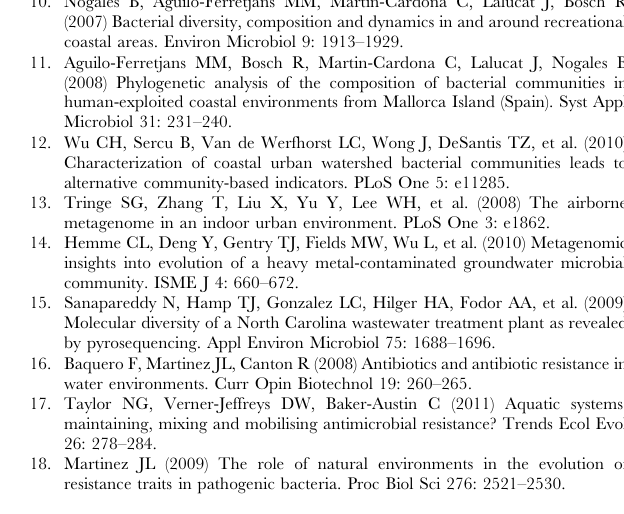
Table S1 Puget Sound 454 sequence reads with $ 80% similarity and an alignment length $ 50 amino acids to sequences within the expanded Antibiotic Resistance Genes Database (ARDB + ). Table S2 Plasmid sequences in the NCBI RefSeq database that match contigs from the Puget Sound and wastewater treatment plant (WWTP) effluent metage- nomic datasets. Table S3 Plasmid sequences in the NCBI RefSeq database that match sequence reads from the Puget Sound and wastewater treatment plant (WWTP) effluent